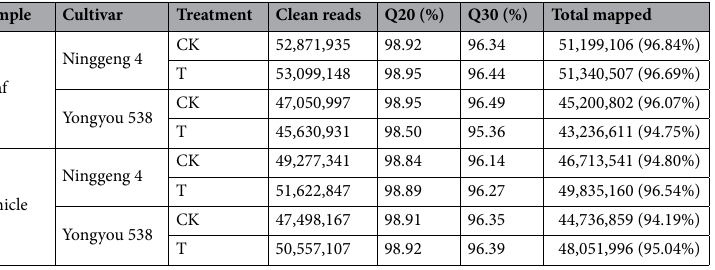
Table 4. Comparison of the sequencing data for the two japonica cultivars sown on two sowing dates with the reference genome. Total reads: The number of sequences after filtering (clean reads); Q20, Q30: The percentage of bases with quality greater than 20 or 30; Total mapped: Number of clean reads that can be mapped to the genome.